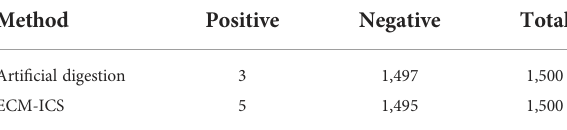
TABLE 1 The results of investigating Trichinella